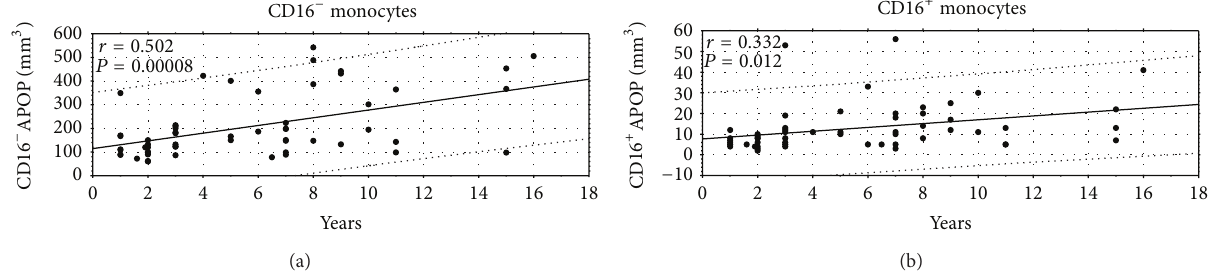
Figure 2: Apoptotic monocyte count in the course of DM1. Apoptotic monocytes were enumerated from the PBMC samples. The relationship between diabetes duration (in years) and absolute values of blood CD16 − and CD16 + Annexin V binding monocytes was analyzed in sixty diabetic patients. Analysis of Annexin V binding monocytes was carried out in gates determining the CD14 versus CD16 positive monocytes. Coefficient “ 𝑟 ” and “ 𝑃 ” values are presented. APOP = apoptotic.